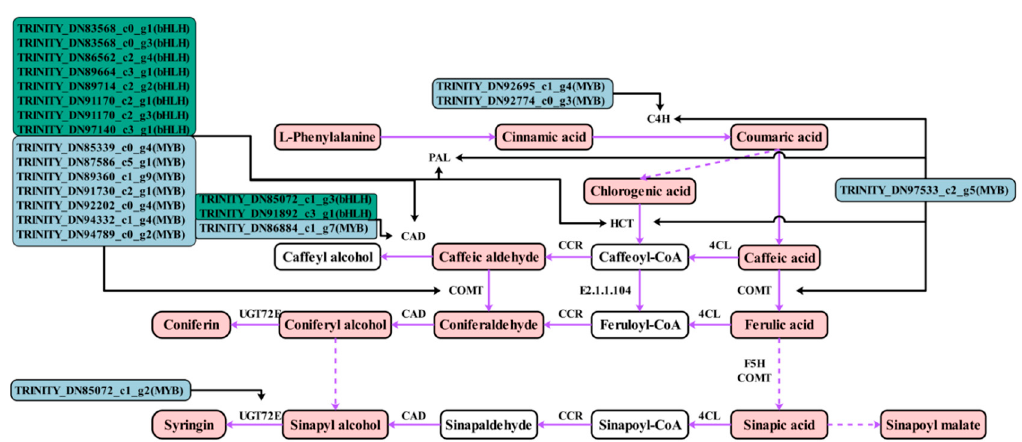
Figure 5. Regulatory network of phenolic acid biosynthesis in the leaves of Cyclocarya paliurus at di ff erent developmental stages. The red squares indicate detected metabolites. The solid frame arrow represents only one step of process and the dotted frame arrow represents more than one step of process. Black arrows indicate possible directions for MYB and bHLH transcription factors. Purple arrows indicate directions for phenolic acid biosynthesis.